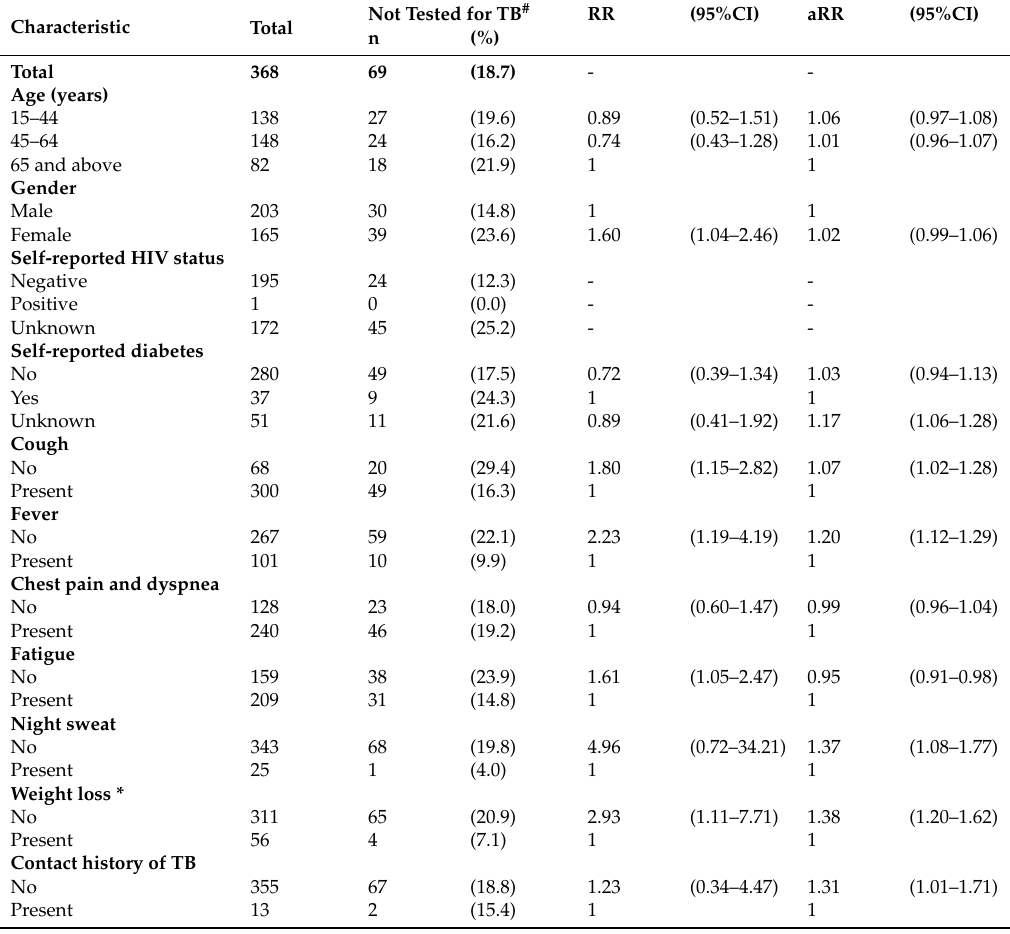
Table 2. Factors associated with ‘not getting tested for TB’ among presumptive TB patients